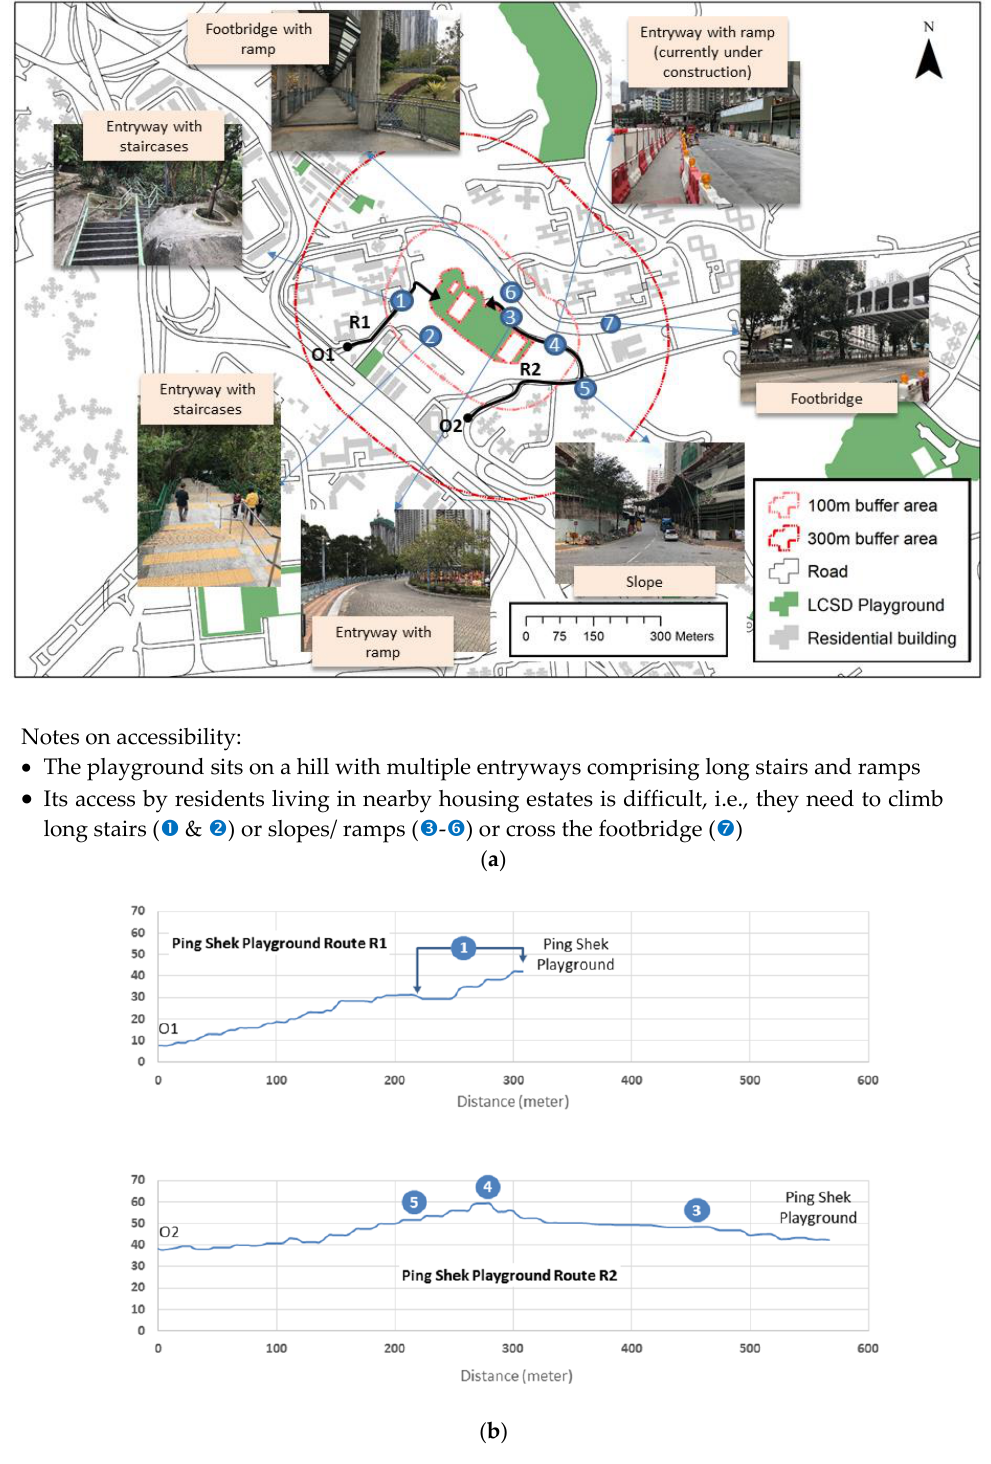
Figure 3. ( a ) Accessibility issues of the Ping Shek Playground in Kwun Tong District, 2016. ( b ) Vertical profiles of routes R1 and R2 to Ping Shek Playground in Kwun Tong District, 2016.